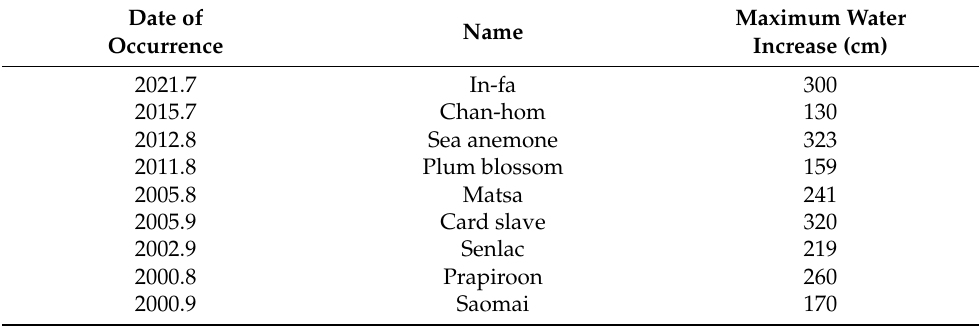
Table 1. Storm surge and maximum water increase affecting Shanghai in recent years